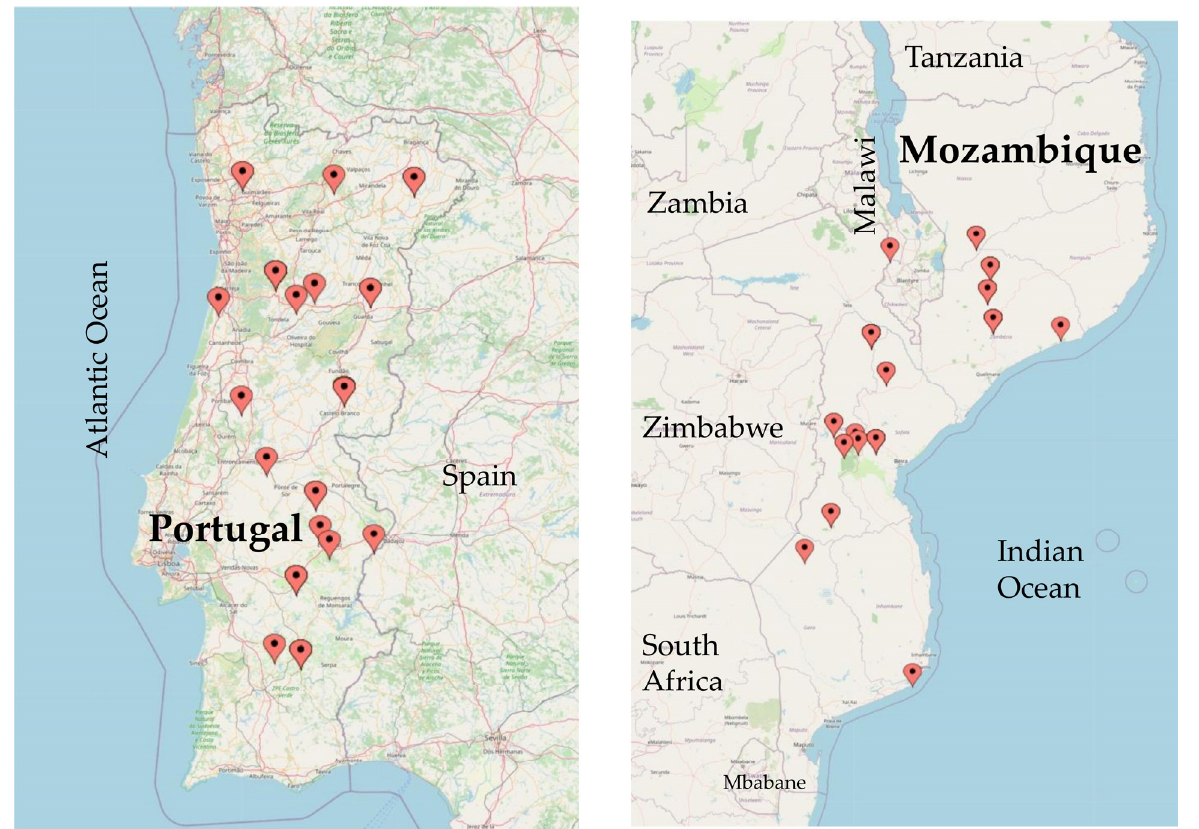
Figure 12. Locations of Portuguese and Mozambican accessions used in this study (https://www.mapcustomizer.com/, accessed on 9 February 2023).